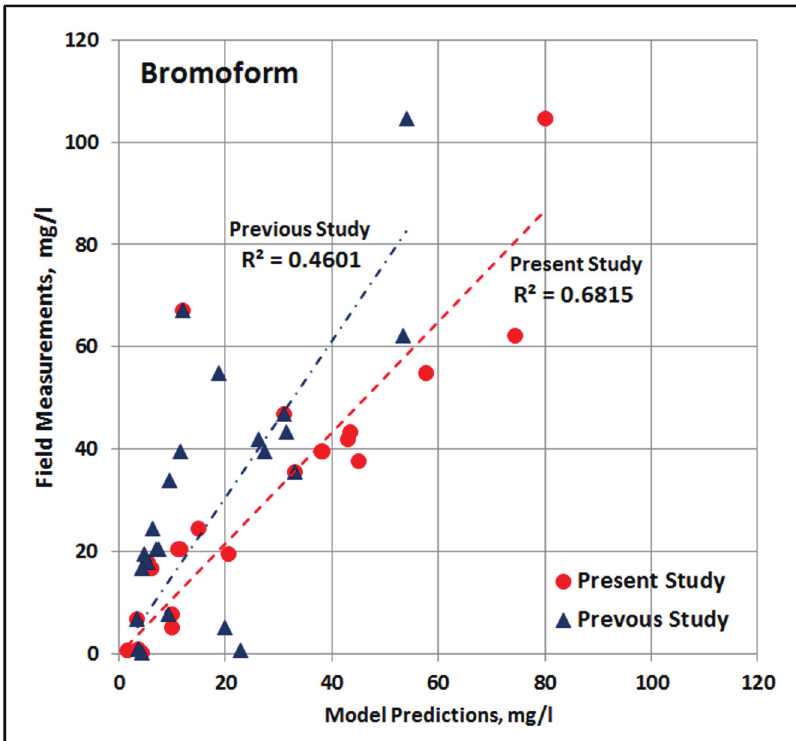
Figure 11. Comparison of GEMSS model predictions vs . field measurements for